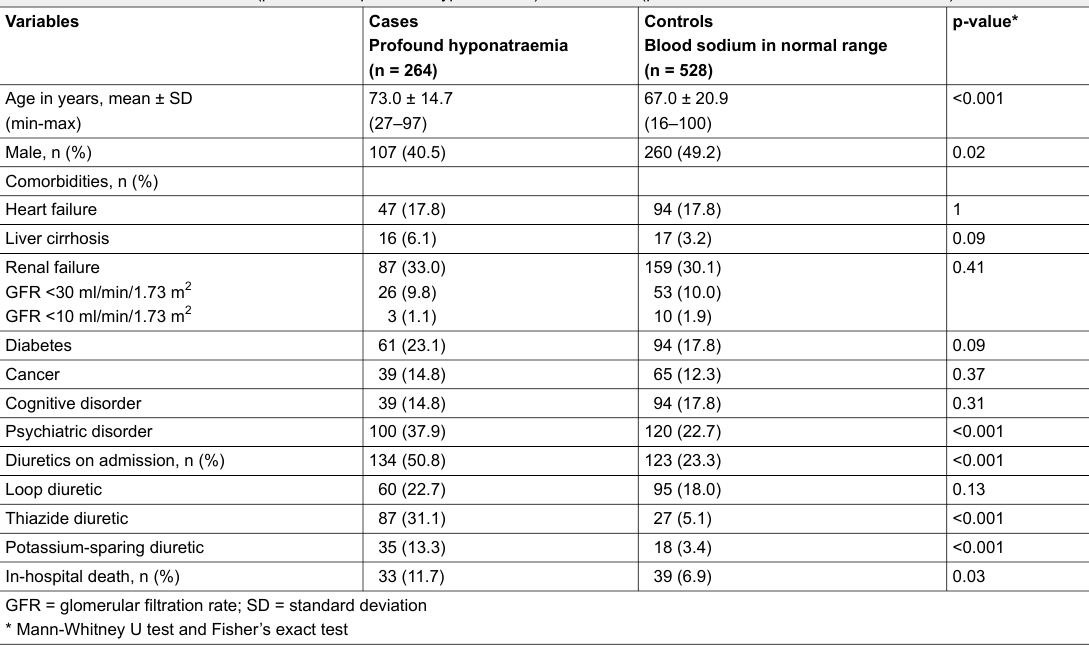
Table 3: Characteristics of cases (patients with profound hyponatremia) and controls (patients with normal blood sodium levels). Variables